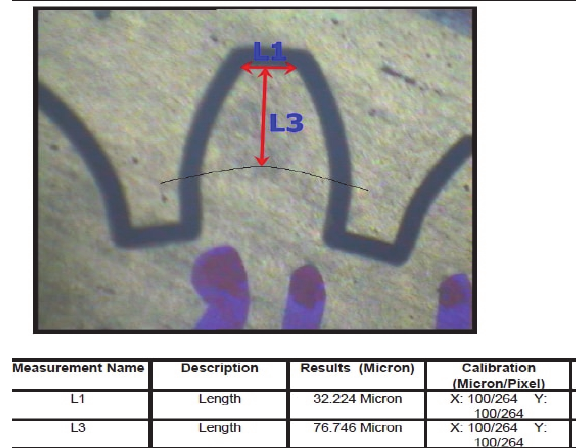
Fig. 11. Nomenclature of the gear parameters Fig. 12. Measurement of the Tooth width and showing Tooth width, Addendum and Addendum at an optimum setting of 20X zoom Dedendum Measurement of Surface roughness, Addendum and Tooth width at optimum setting Optimum